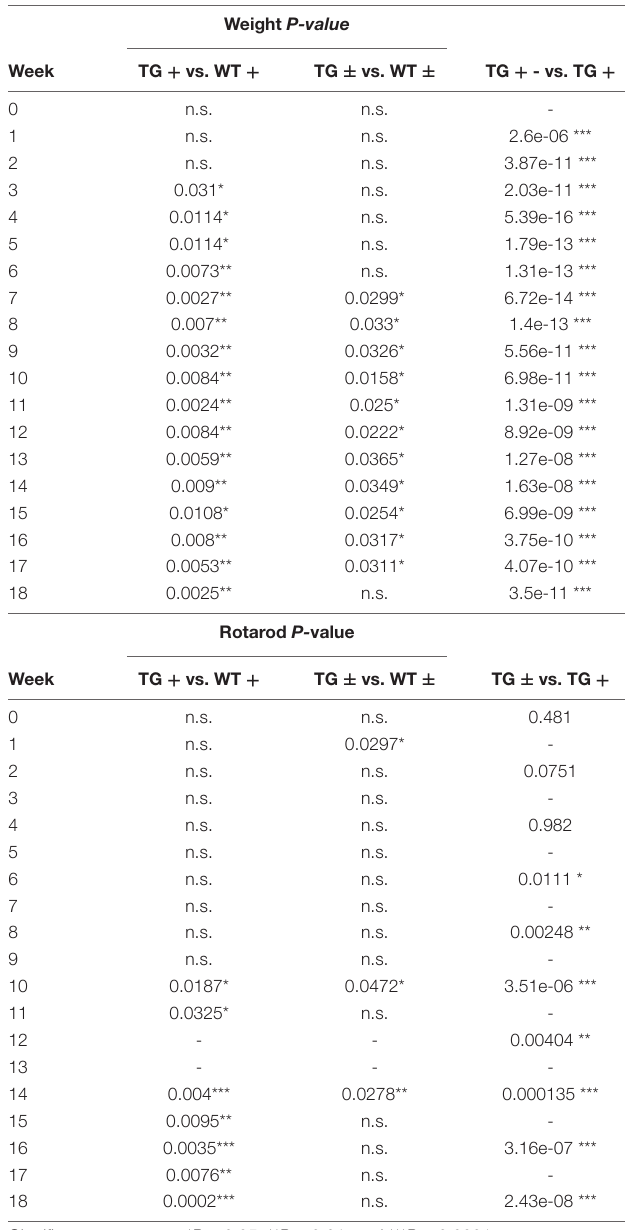
TABLE 2 | P values for Two-way repeated-measures ANOVA with Tukey’s post hoc for animal weight and rotarod ( Figures 1B,C ). Weight